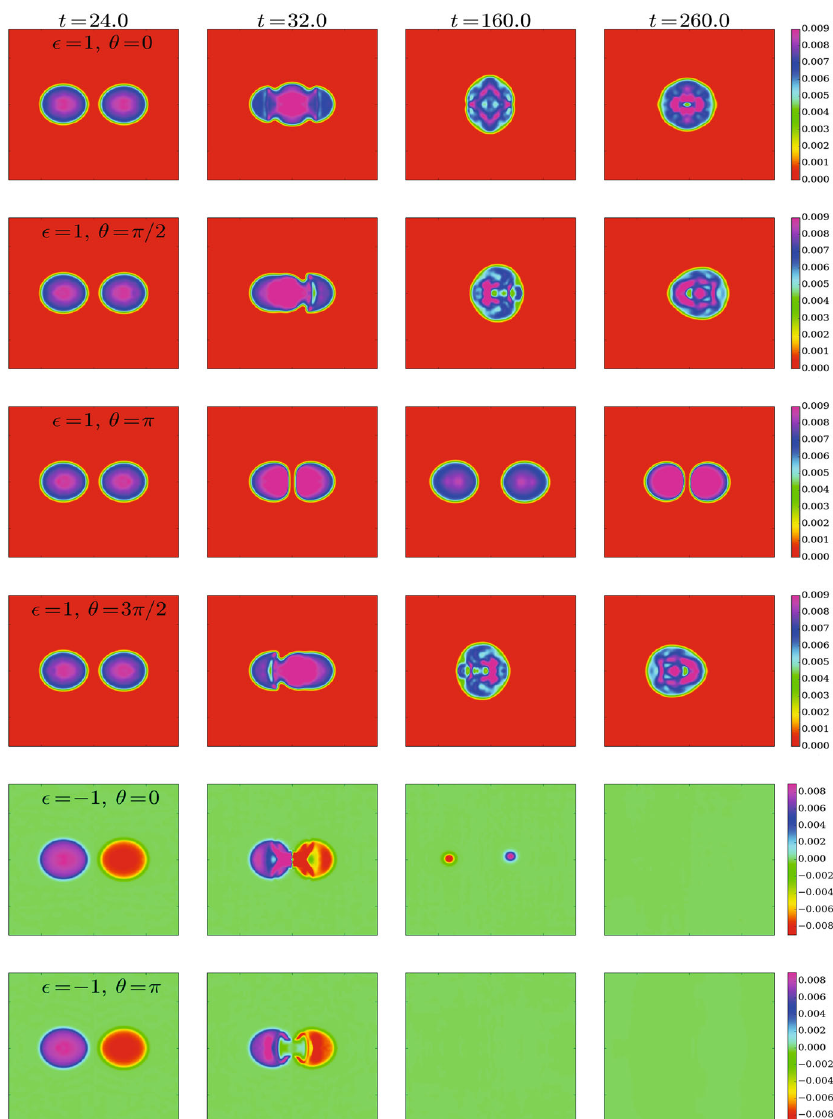
Fig. 20 Snapshots in time of the Noether charge density in the z = 0 plane for head-on binary collisions of compact solitonic boson stars. Each row corresponds to a different boson-boson and boson-anti-boson case studied with a phase shift θ as described by Eq. (90). The collision of the stars occurs approximately at t = 28. The result of the boson–boson merger is a single boson star except in the case with θ = π . The stars in the boson–anti-boson case annihilate each other during the merger. Reprinted with permission from Bezares et al. (2017); copyright by